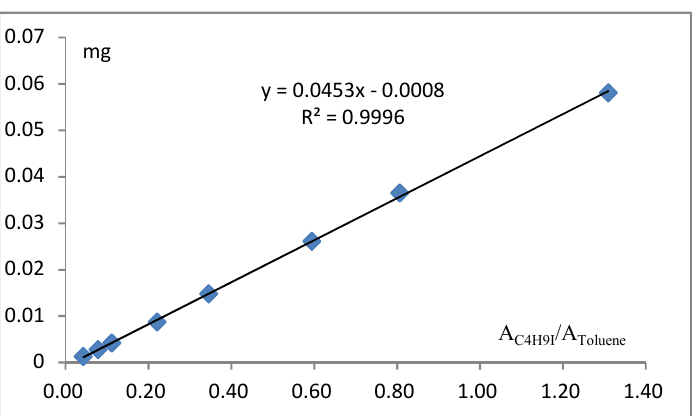
Figure 2. The linear curve of reference substance of 2-iodobutane.